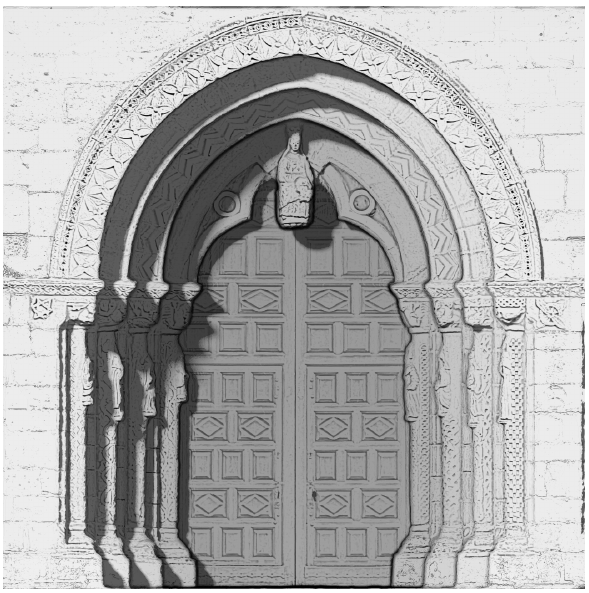
Figure 12: Synthetic drawing created from the processing and composition of multiple layers, removing color information and adding edge and shading, with the purpose showing only the de- tails in shape and fine